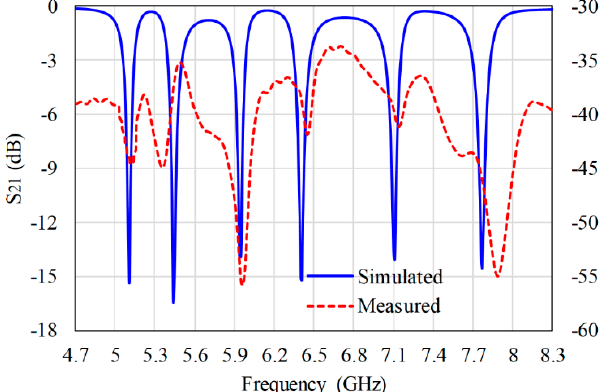
Figure 19. Measured and simulated S 21 of code 101010101010.